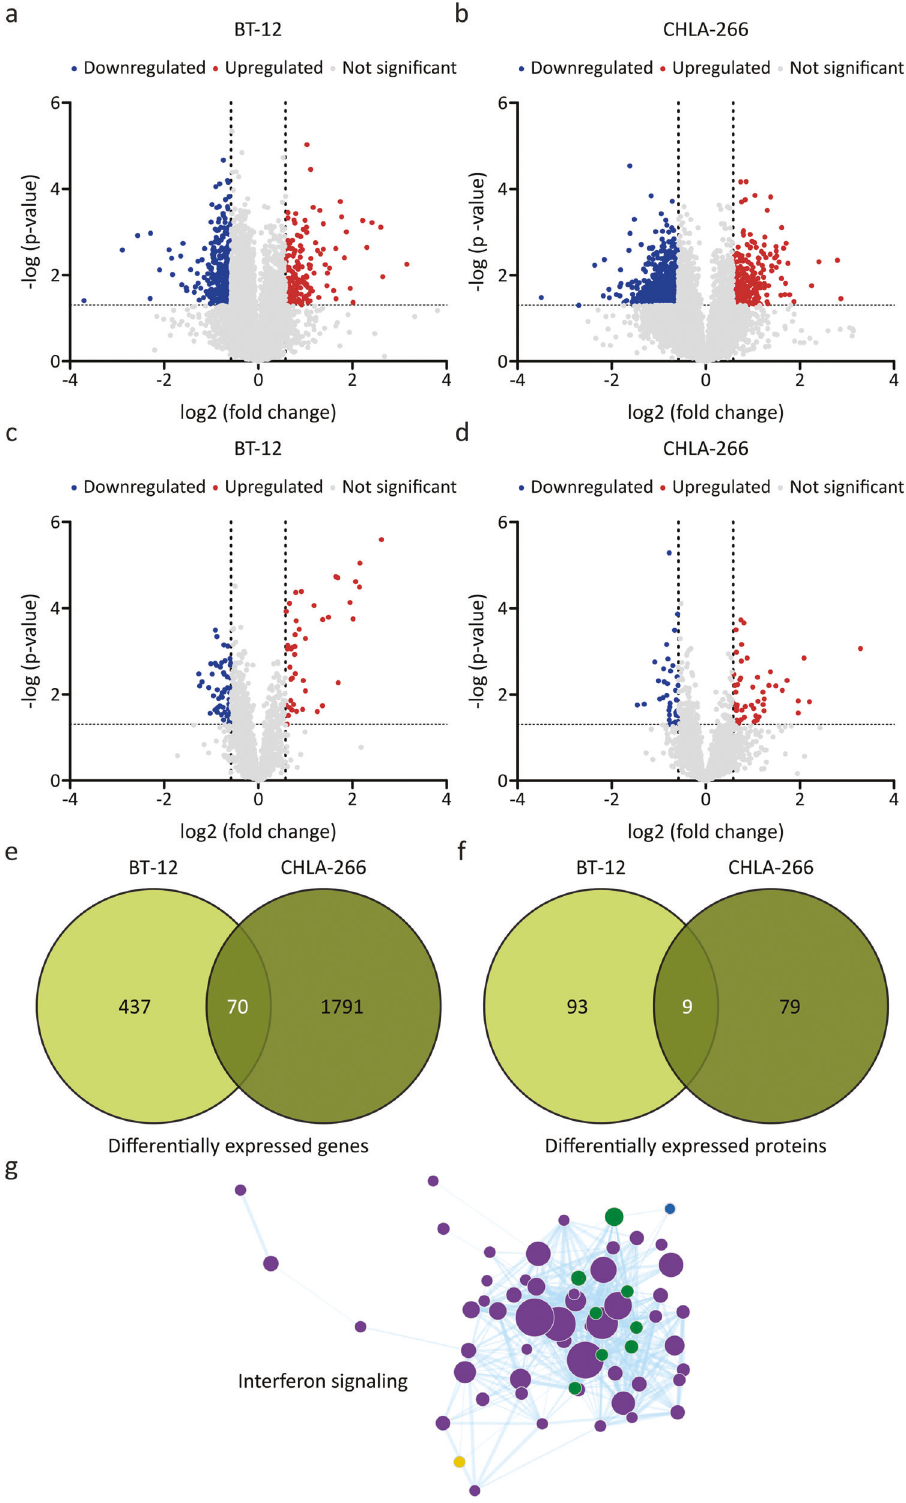
Fig. 4 Proteogenomic pro fi ling reveals induction of interferon signaling following kinesin family member 3A ( KIF3A ) knockdown in the AT/RT cell lines BT ‐ 12 and CHLA ‐ 266. a – d Volcano plots showing downregulated (blue dots), upregulated (red dots) and not signi fi cant (grey dots) transcripts ( a , b ) and proteins ( c , d ) following KIF3A knockdown in BT ‐ 12 ( a , c ) and CHLA ‐ 266 ( b , d ) cells, using a minimal fold change of ± 1.5 and a signi fi cance level of p < 0.05 as a cut ‐ off. Statistical analysis was performed using the non ‐ parametric Kruskal Wallis test. e , f Venn diagrams showing the overlap of differentially regulated genes ( e ) and proteins ( f ) between BT ‐ 12 and CHLA ‐ 266 cells. g Gene set enrichment analysis (GSEA) was performed for merged RNA sequencing and proteomics data. Green circles: Overlap between mass spectrometry (MS) and RNA sequencing (RS) upregulated in KIF3A knockdown cells. Purple circles: Upregulated in MS KIF3A knockdown cells. Blue circles: Upregulated in RS KIF3A knockdown cells. Yellow circle: Upregulated in MS control cells. Cell Death and Disease (2022)